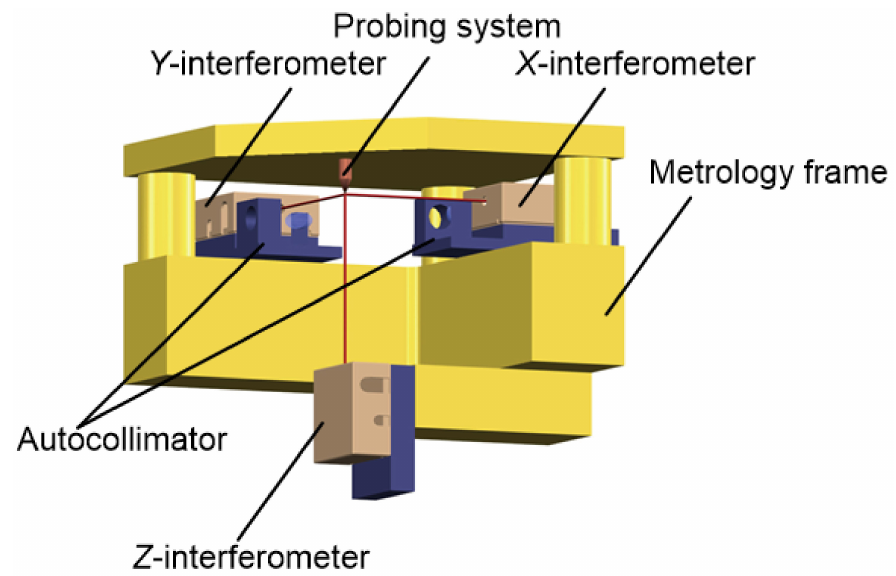
Figure 1. Metrological structure of NMM-1 (Courtesy of